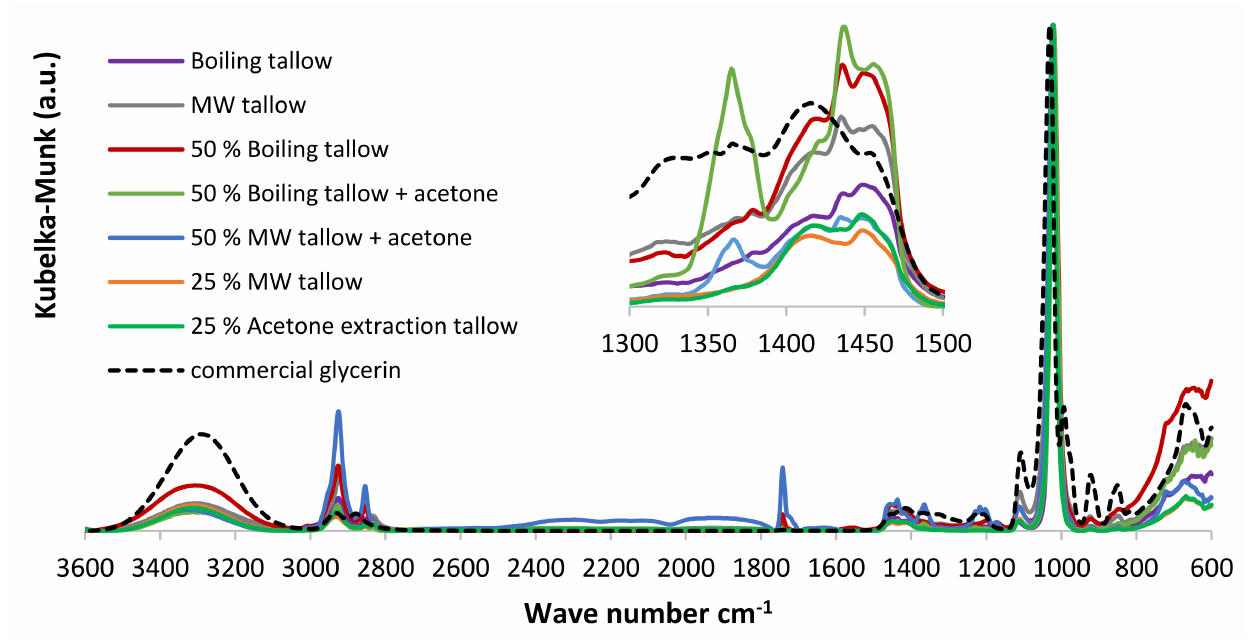
Figure 9. ATR-FTIR spectra of glycerin coproduced with biodiesel and commercial glycerin used as